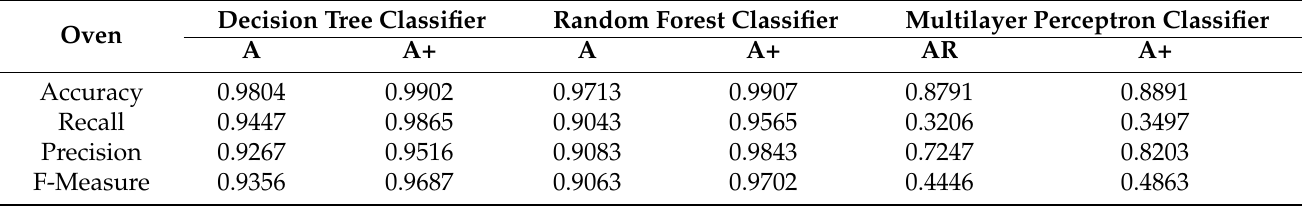
Table 2. Results for the oven. With “A” we refer to the experiments that used only active power. With “AR” we refer to experiments with active and reactive power and with “A + ” we refer to experiments with all the selected attributes. Oven